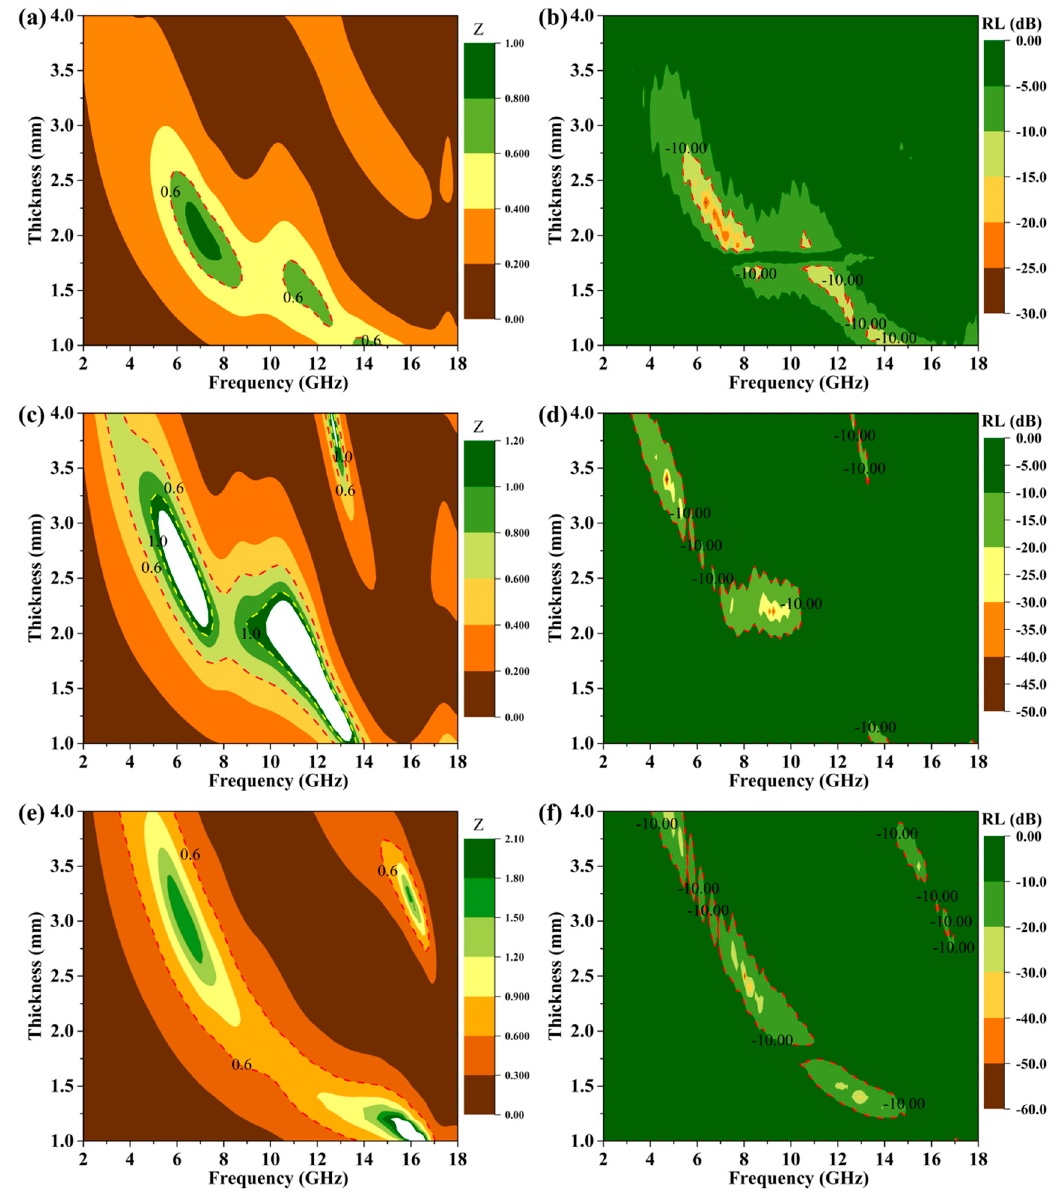
Figure 9. Z and RL contour maps of GNPs@Ni x S y @MoS 2 -1 composite ( a , b ), GNPs@Ni x S y @MoS 2 -2 composite ( c , d ), GNPs@Ni x S y @MoS 2 -3 composite ( e , f ).